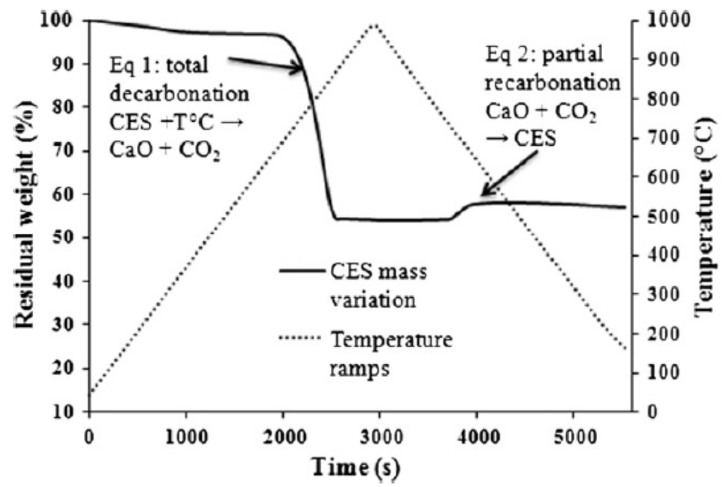
Figure 3. TGA analysis of chicken eggshell (CES) [26].